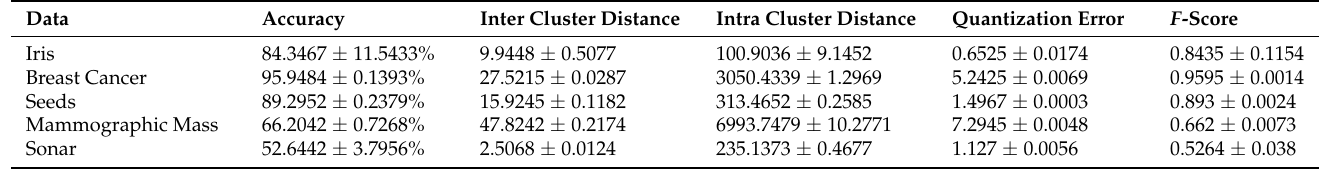
Table 3. Results from the K-Means Algorithm.